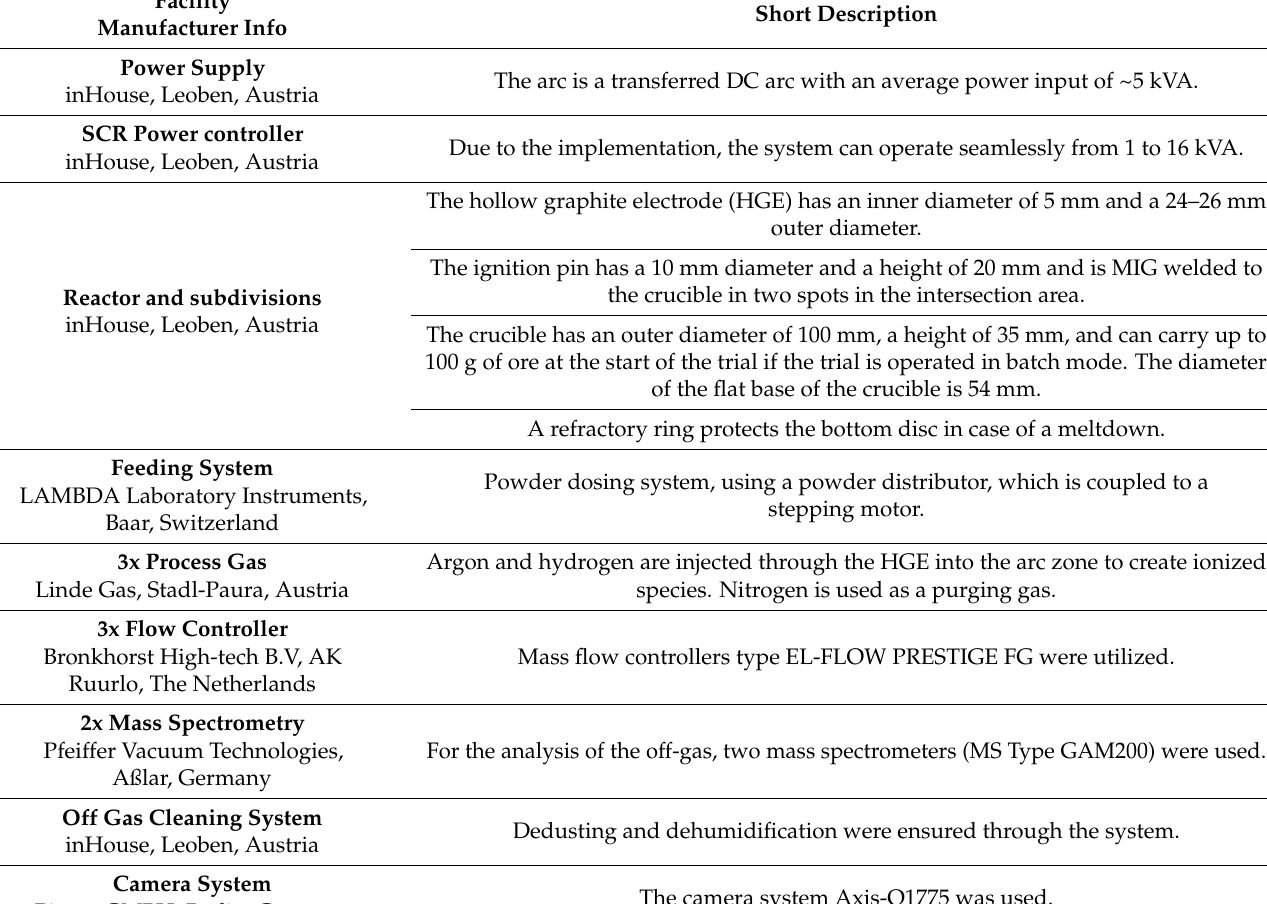
Table 1. Equipment of the HPSR laboratory facilities at the Chair of Ferrous